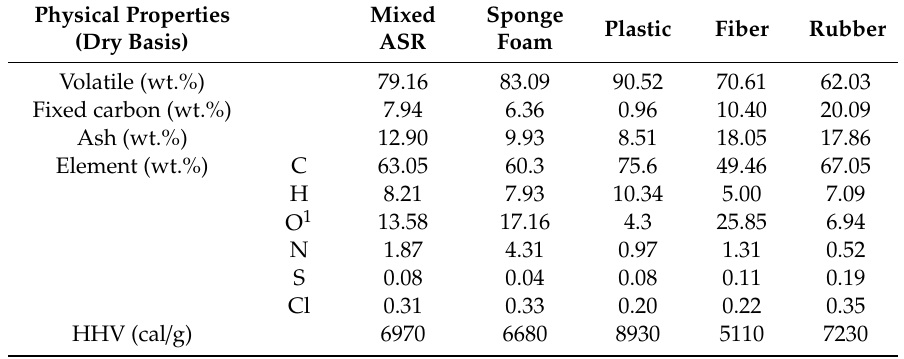
Mixed Sponge Plastic Fiber Rubber ASR Foam